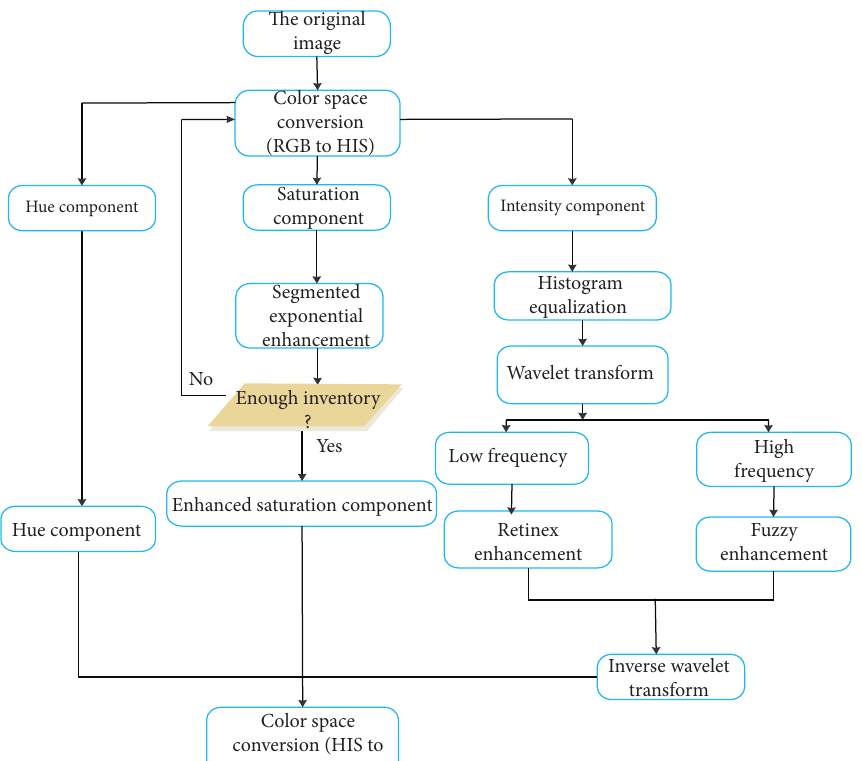
Figure 3: RGB and HSI tone space